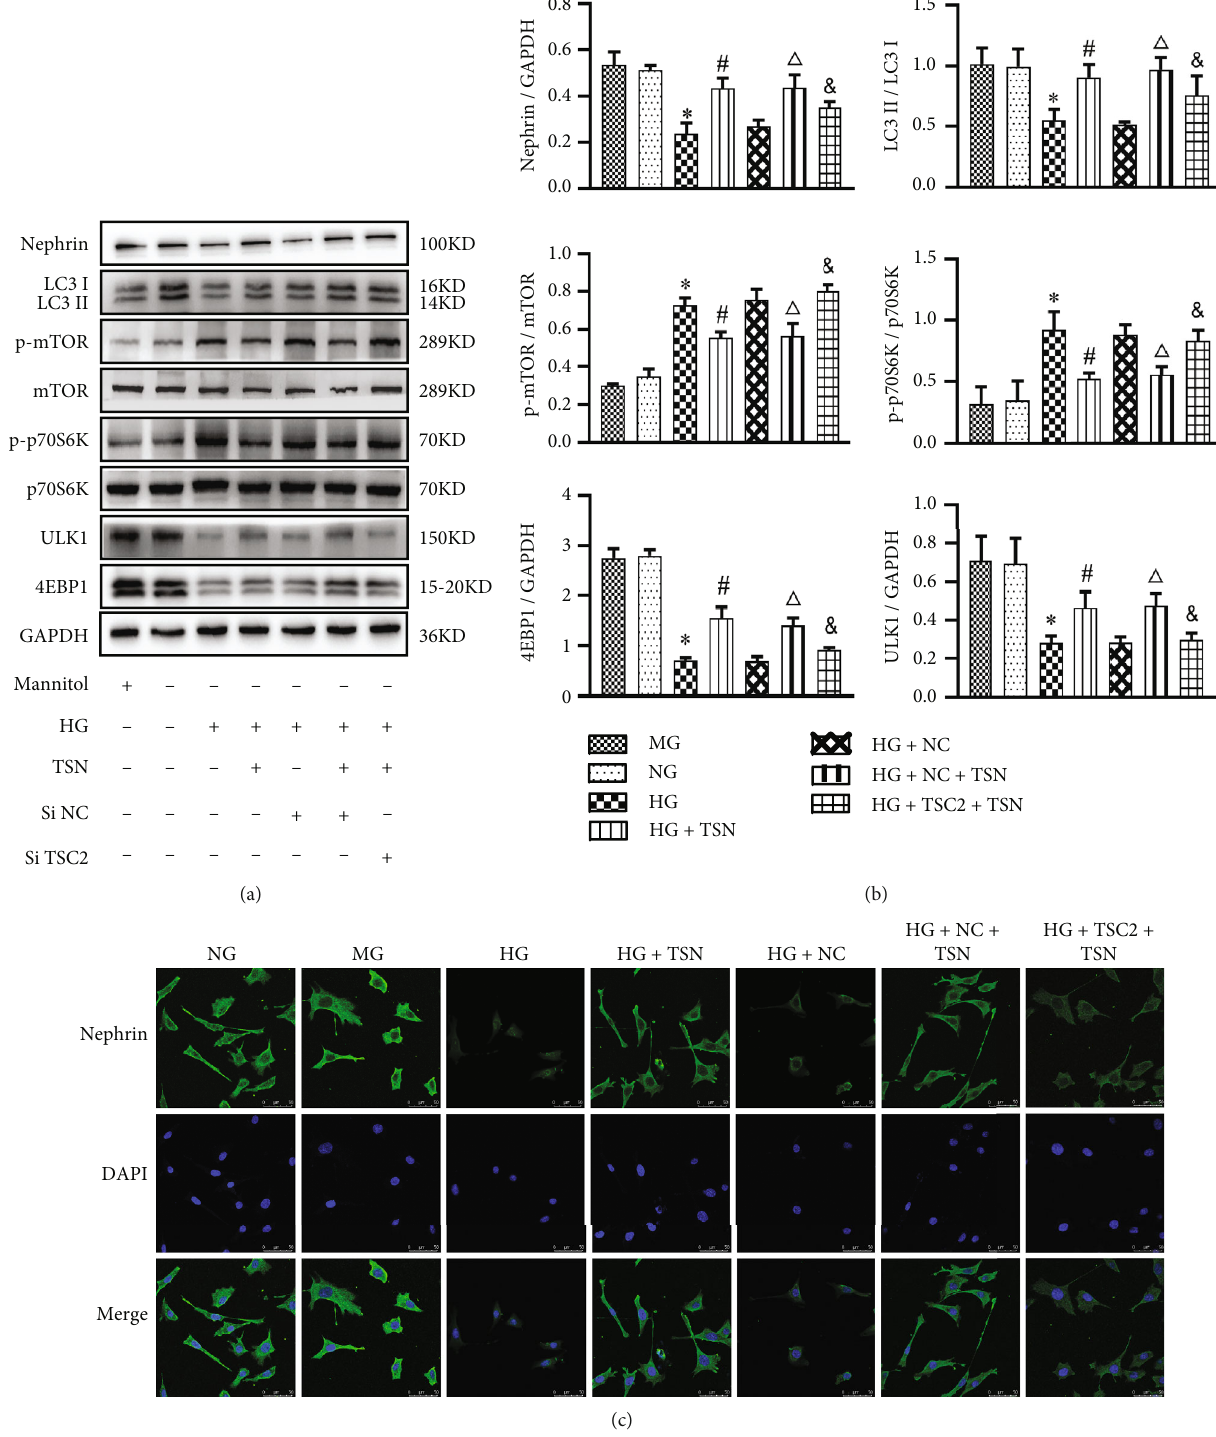
Figure 7: E ff ect of TSN on the mTORC1 activation, LC3II, and nephrin in high glucose-induced podocytes. (a – b) Representative Western blot bands and quanti fi cation of nephrin, LC3II/I, mTOR, p-mTOR, p-p70S6K, p70S6K, ULK1, and 4EBP1 protein expression. Data were shown as the mean ± SD , n = 3 ; ∗ P < 0 : 05 versus the NG group, # P < 0 : 05 versus the HG group, △ P < 0 : 05 versus the HG + NC group, & P < 0 : 05 versus the HG + NC+ TSN group. (c) Representative immuno fl uorescence photographs of nephrin in each group, magni fi cation × 630, scale 50 μ m, n = 3